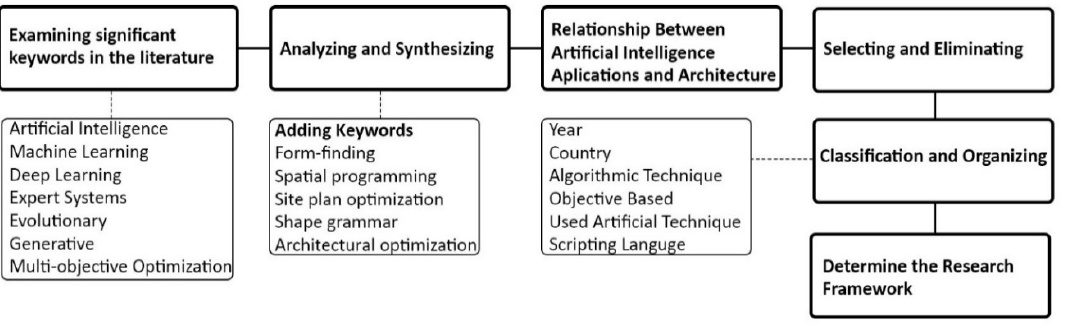
Figure 1 Research